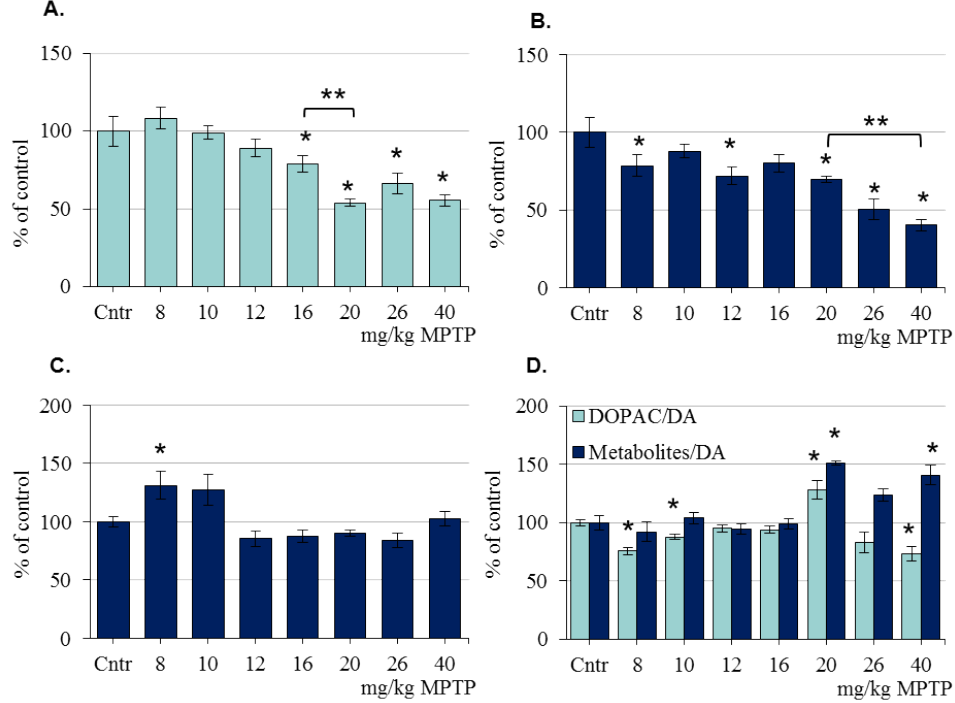
Table S2). After the 4th administration of MPTP (16 mg/kg), the content of DA decreased